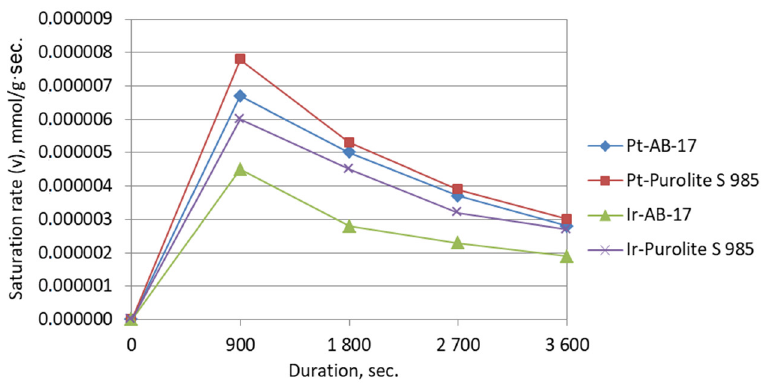
Figure 4. Kinetic curves of platinum and iridium joint sorption from sulfate-chloride solution: С Me = 0.26 mmol/L; C H2SO4 = 0.5 mol/L; C HCl = 0.5 mol/L.